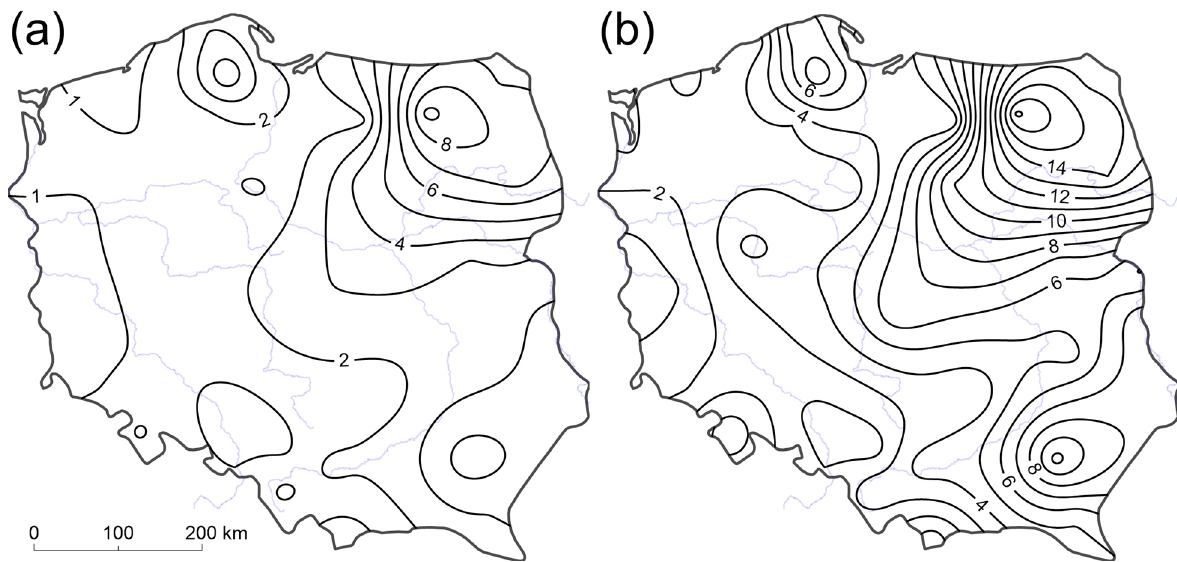
Fig. 2. Mean frequency of occurrence (%) of very strong and extreme cold stress according to the UTCI in Poland in the period November to March (A) and January (B), 1966/67 to 2018/19. UTCI, Universal Thermal Climate